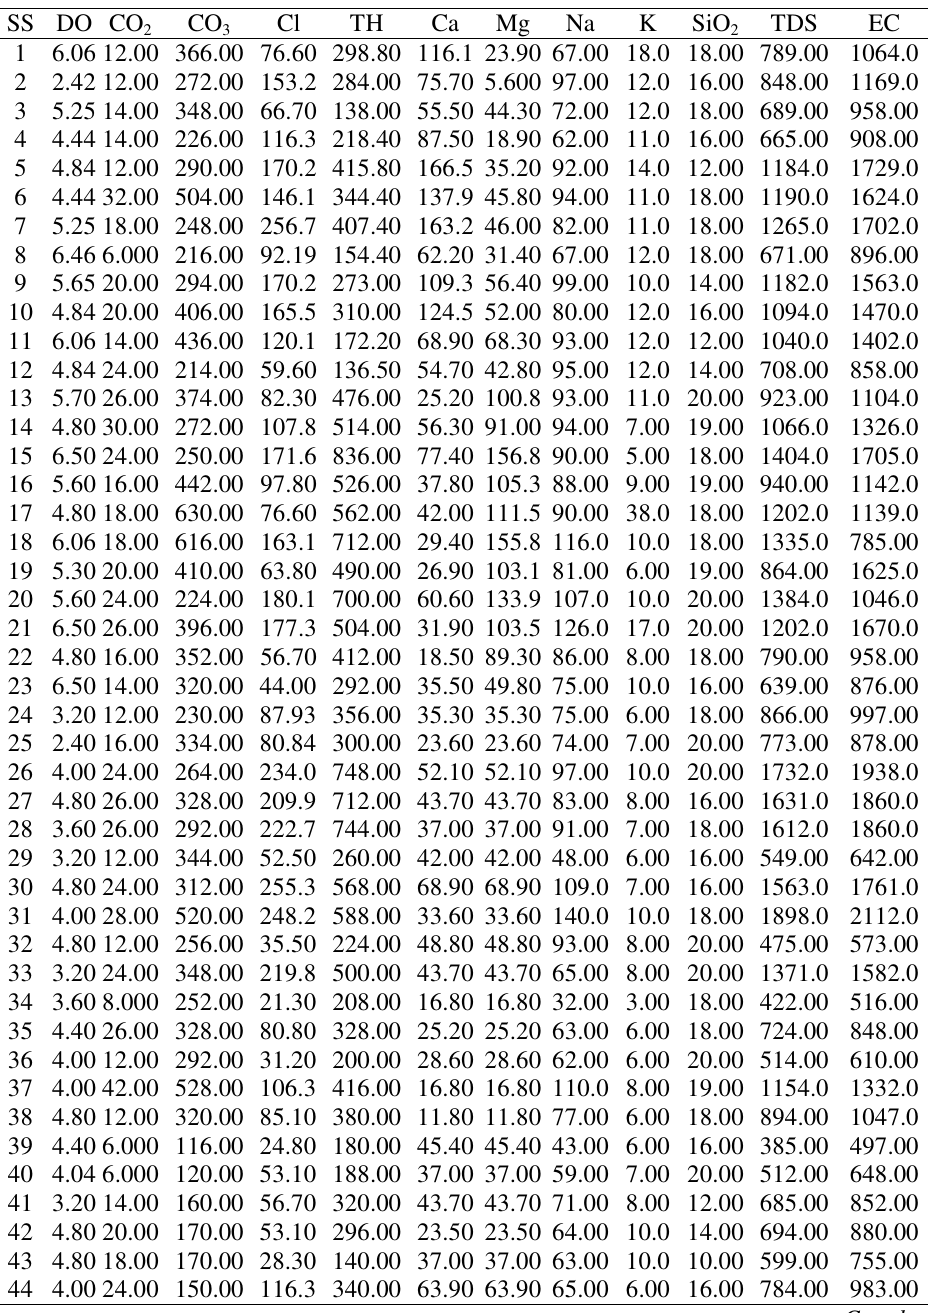
Table 3. Chemical composition of groundwater from different localities of Moradabad